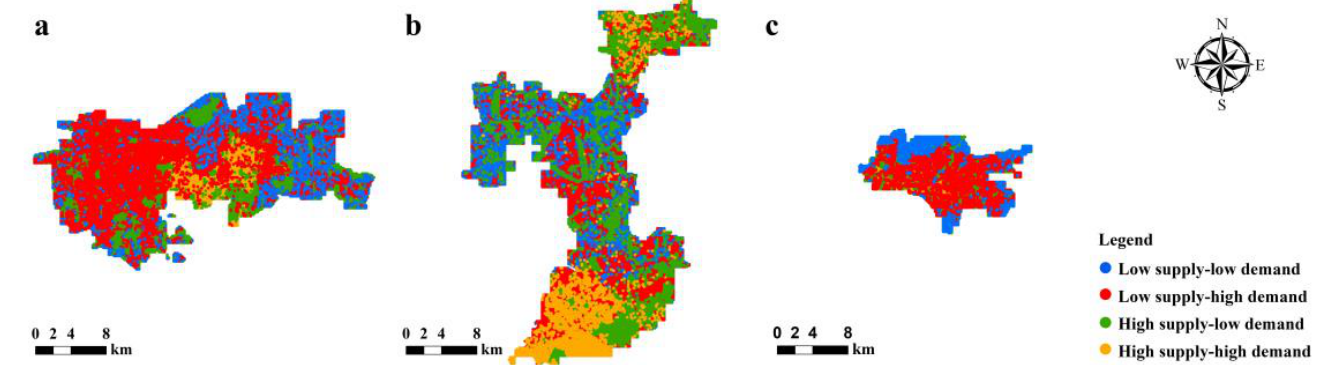
Figure 7. Distribution of CIS and CID matching types: ( a ) Jinan, ( b ) Qingdao, and ( c ) Heze.